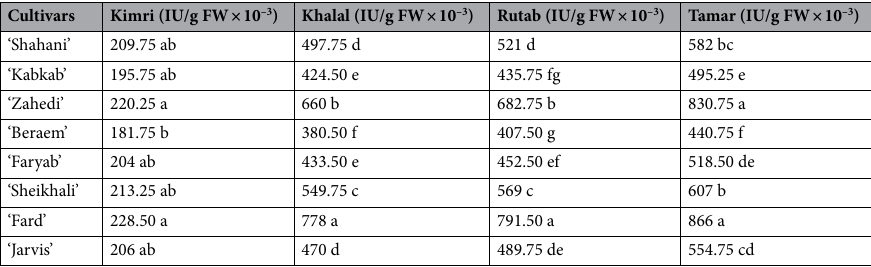
Table 10. Cellulase enzyme activity of ‘Piarom’ date fruit in kimri, khalal, rutab and tamar stages after pollination with eight pollinating cultivars. Different letters within columns indicate significant differences according to Duncan’s multiple range test (p < 0.05).